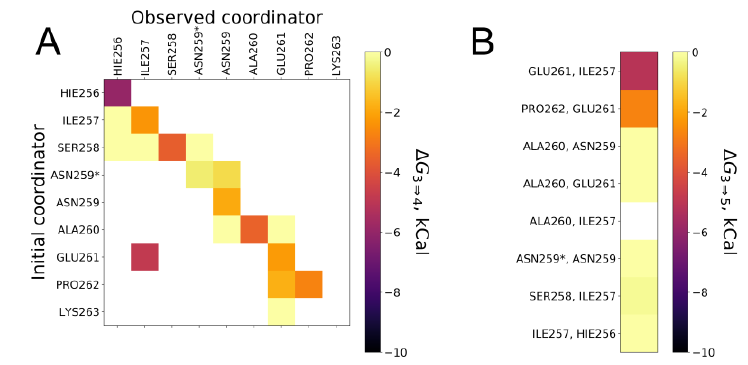
Figure 4. Screening for fourth and fifth chelators for Zn 2 + in ALR peptide while other chelators are: N δ His256, N δ His264, and O δ Glu261. All chelators’ names correspond to the backbone oxygen atom, except ASN259* is O δ . ∆ G values were estimated from simulations of systems initially built according to the abscissa names, while the axis represents observed coordination and corresponding energy values. ( A ) Matrix of ∆ G values between four and three-coordinate state of Zn 2 + , ( B ) Column of ∆ G values where the five-coordination sphere of Zn 2 + was observed in